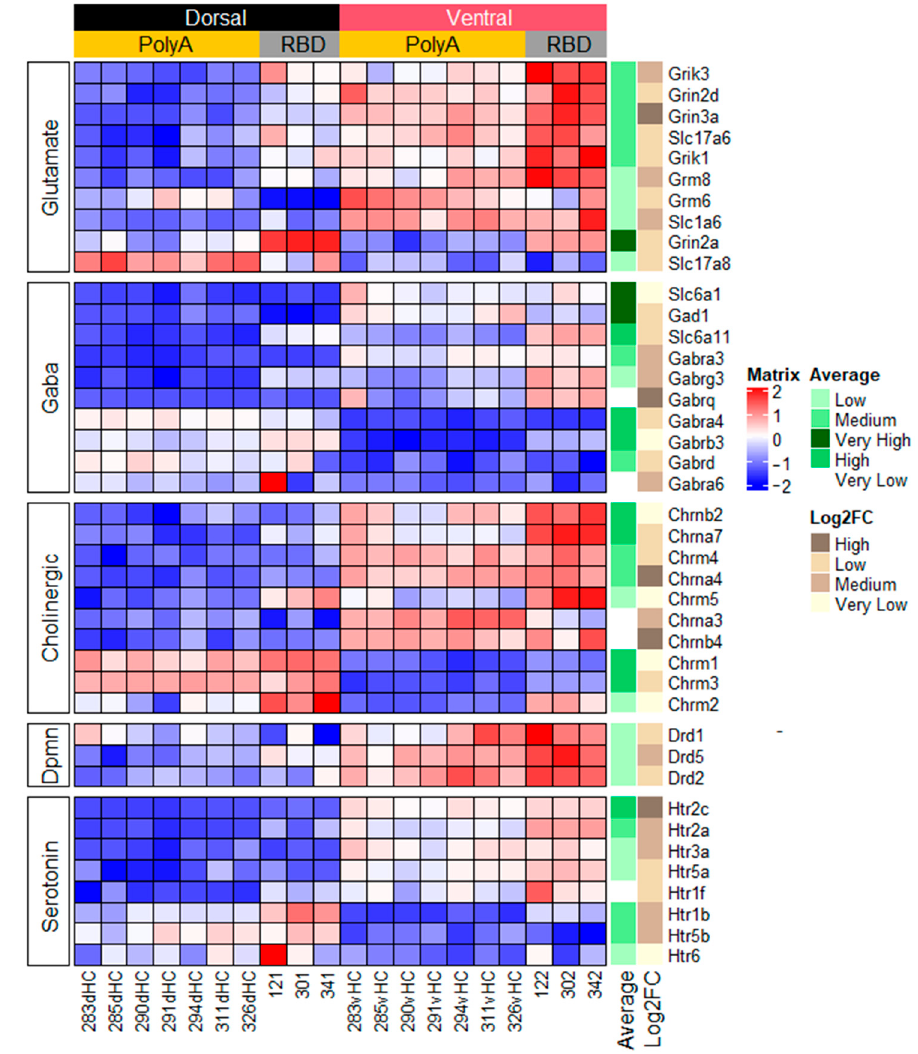
Figure 2. Heatmap showing 10 most DE genes for 5 KEGG categories, related to classical neurotransmitter signaling. Colors represent variation around the mean, red color signifies higher expression values. Average (gradation of green) represents mean expression across all datasets. We discretized average values as follows: Very Low, <50 normalized counts; Low, 50–300; Middle, 300–1000; High, 1000–5000; Very High, >5000. Log 2 FC (gradations of brown) is absolute log 2 fold change with sign depending on heatmap color. Log 2 FC values were discretized as follows: Very Low, <0.5; Low, 0.5–1; Middle, 1–2; High, >2. Dpmn, dopamine.